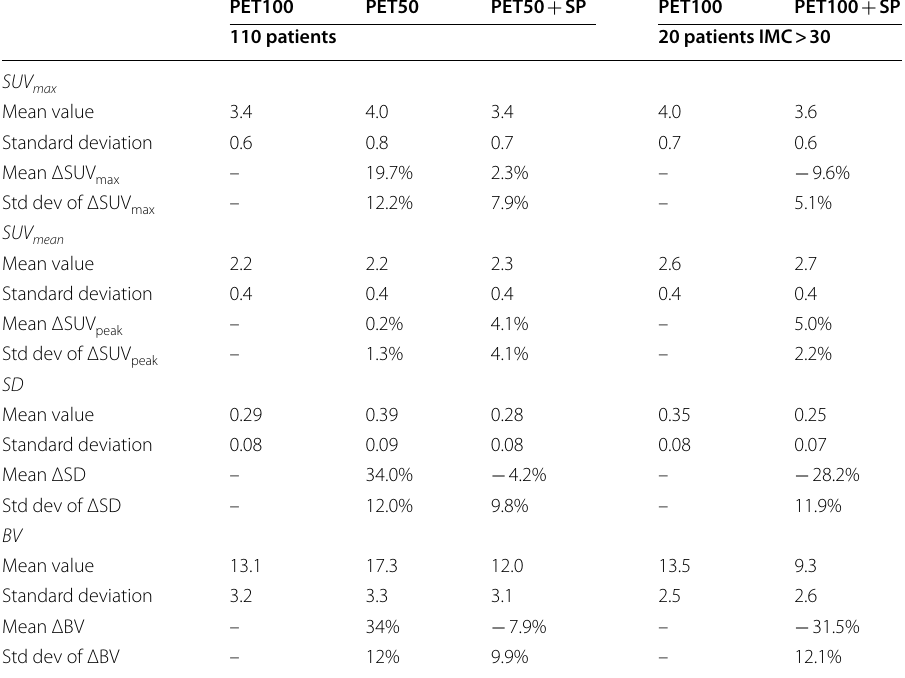
SP series of our patients +